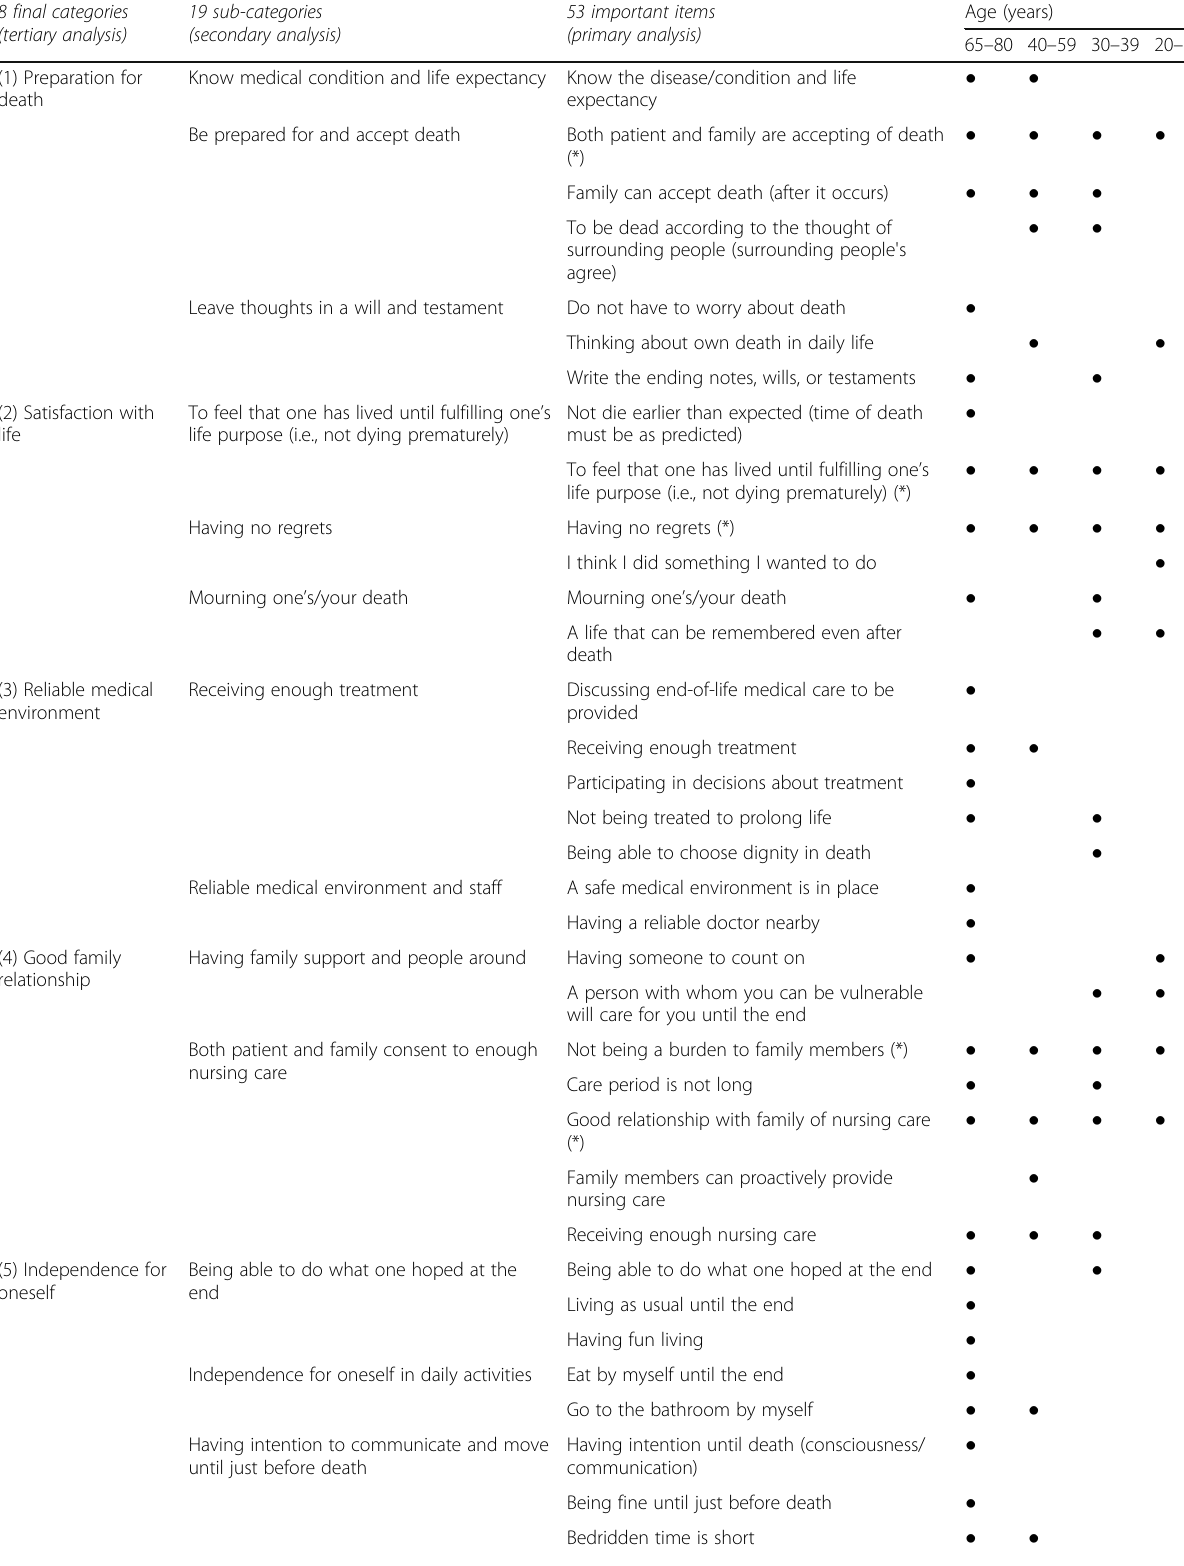
Table 3 Eight important categories of “ Desirable Death ” and nine important items common to all generations 8 final categories (tertiary